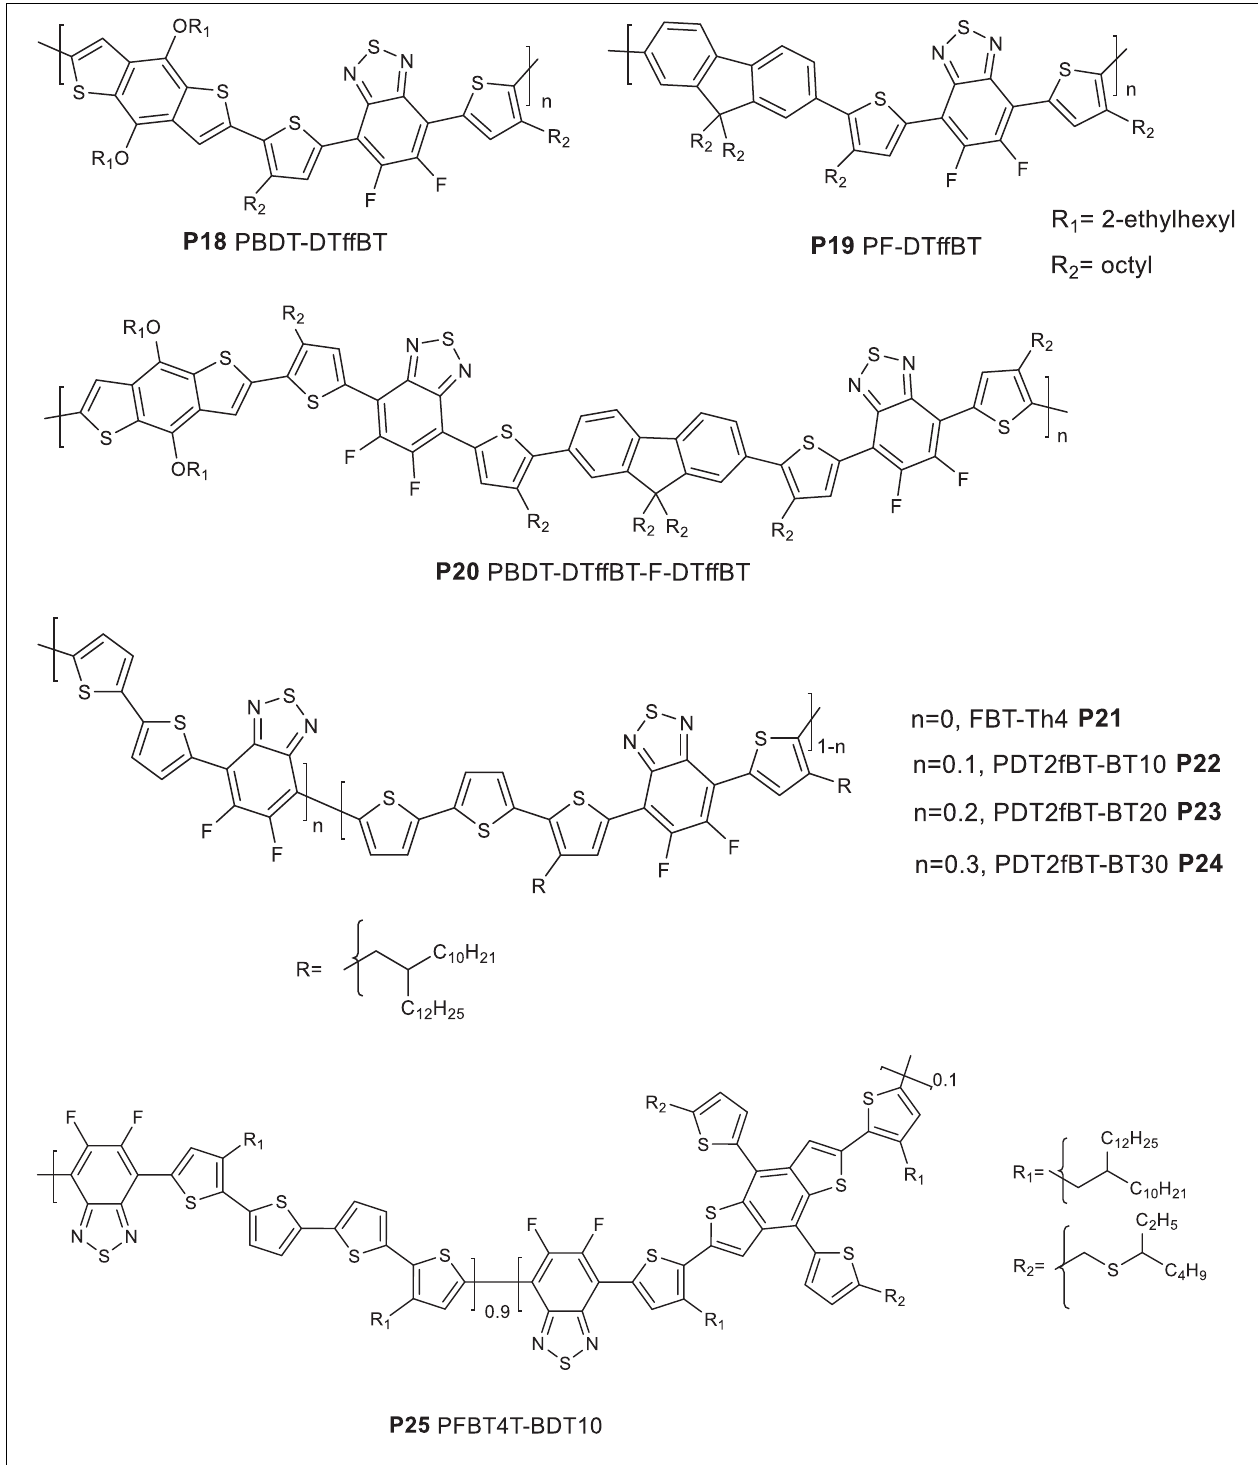
FIGURE 3 | Donor polymers with benzothiadiazole acceptor molecular units ( P18 – P25 ).